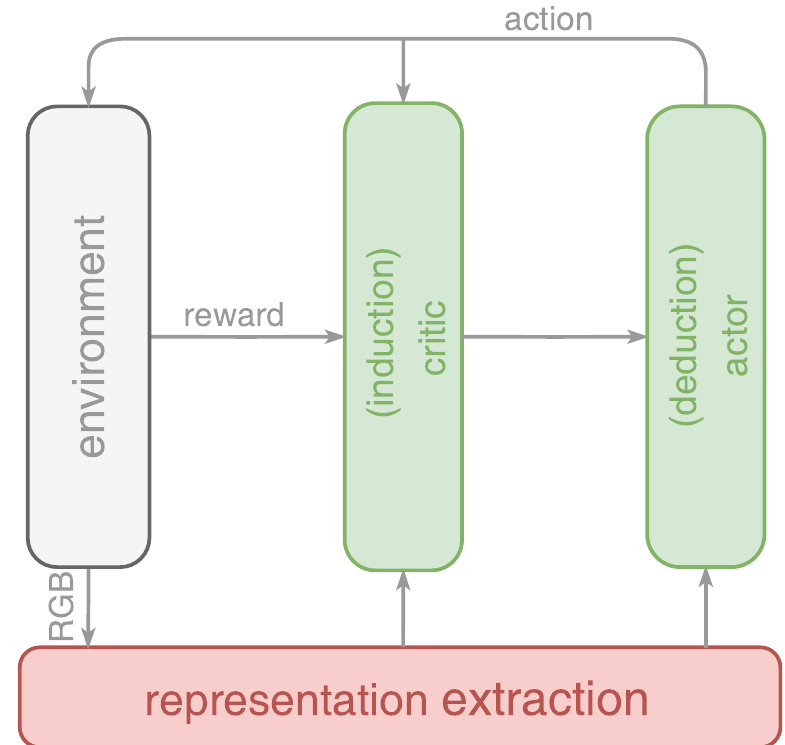
Figure 2. Evaluation framework. The representation learning is separated from policy learning so that different representation distillation modules can be embedded into reinforcement learning (RL) without changing the architecture and parameters of policy learning